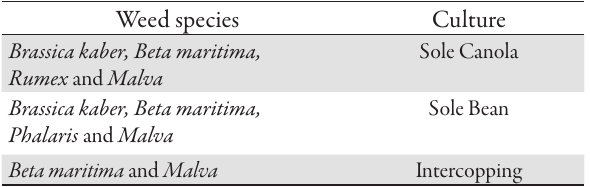
Tab. 4. Diversity of weed species is in sole and intercropping